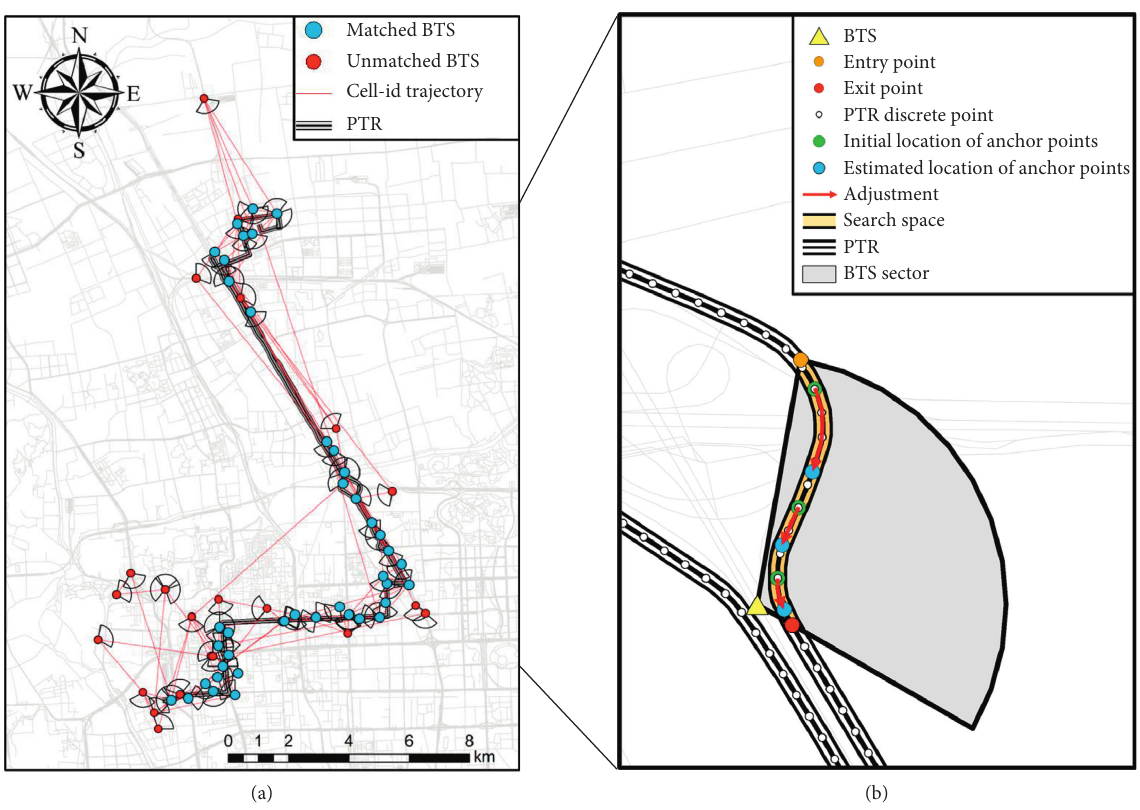
Figure 7: Anchor point’s search space in a matched BTS sector.